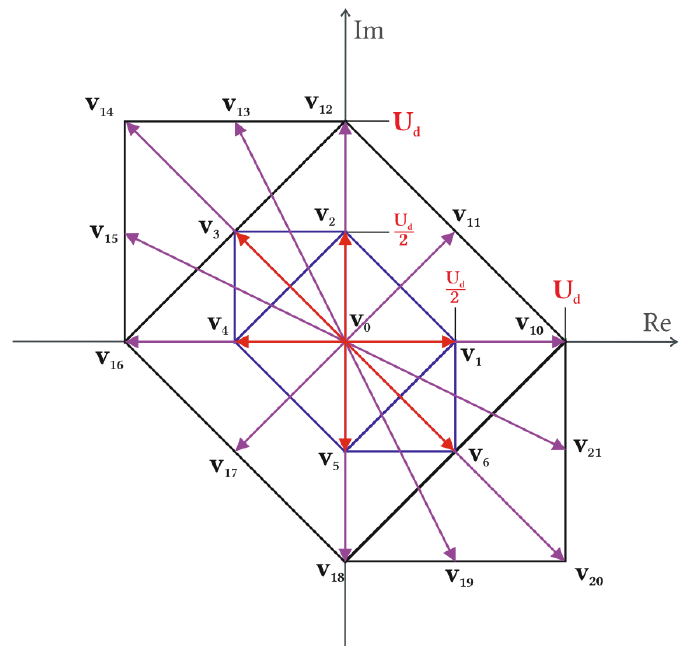
Figure 3. Nineteen output phase-to-phase voltage vectors of the two-phase 3L-NPC inverter repre- sented in an α – β complex space forming a hexagon.